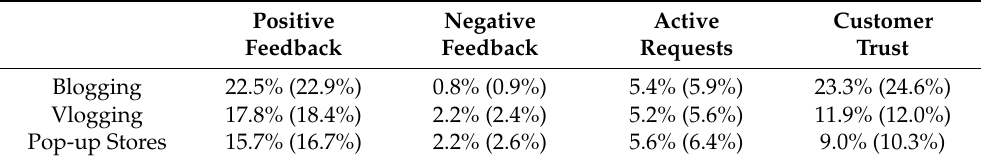
Table 5. Frequent customer participation (always or often) by type of new professional service. Numbers in brackets refer to the 18–34 years of age customer